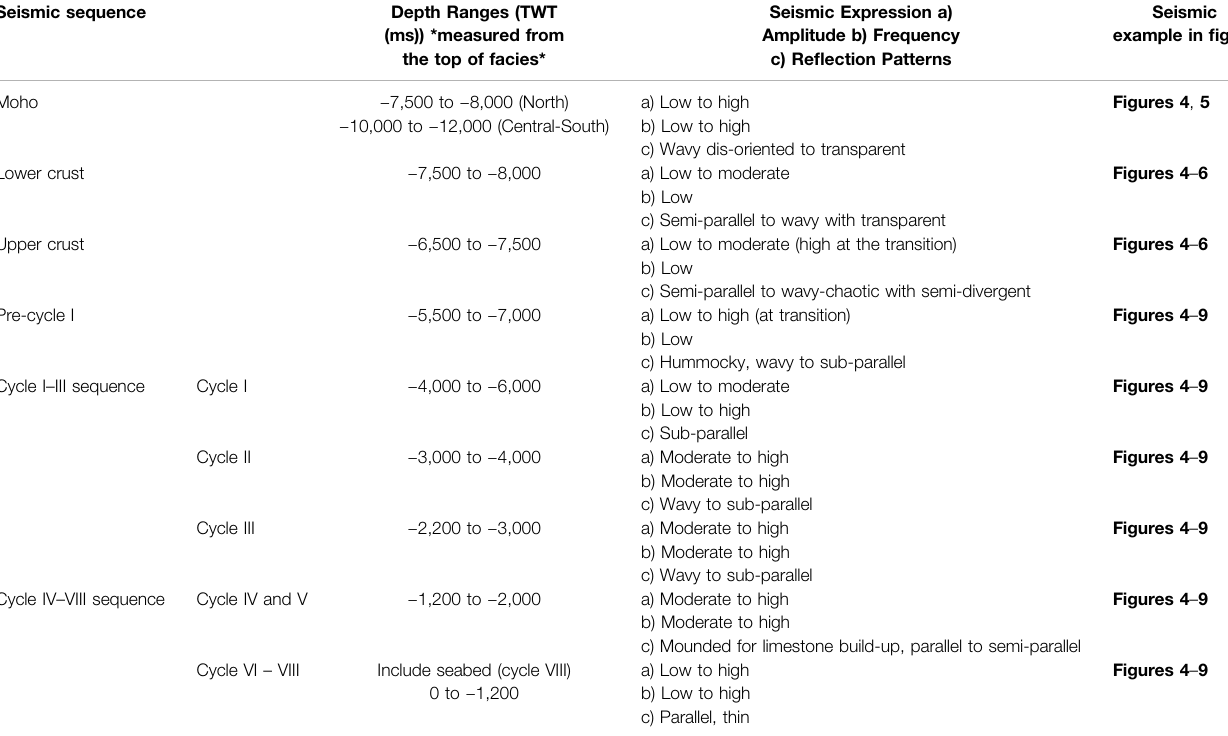
TABLE 1 | Summary of the characteristic and seismic expression for each seismic sequence interpreted in this paper. Seismic